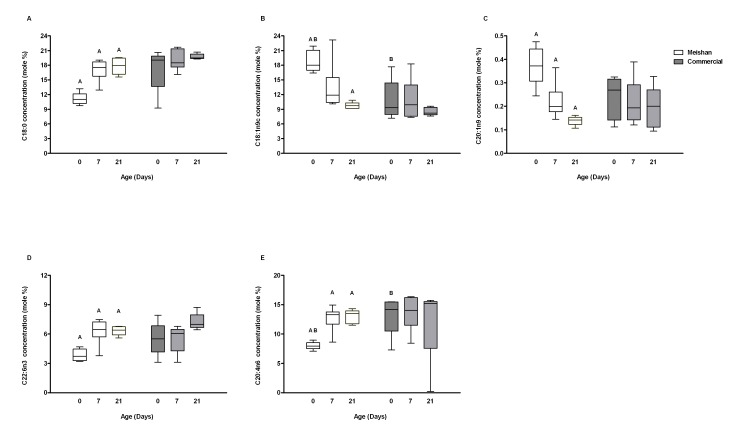
Fatty acid profiles.Differences of the major fatty acids in the livers of Meishan (open bars) and commercial (grey bars) piglets over the first 21 days of postnatal life. (A) stearic acid, (B) heptadecanoic acid, (C) oleic acid, (D) eicosenoic acid (E) arachidonic acid, (F) docosahexaenoic acid. A; p<0.05: statistical difference between the 0 and the other age groups within Meishan breed group. B; p<0.05: Statistical difference between the same postnatal age groups. Bar graphs illustrate means ± SEM.